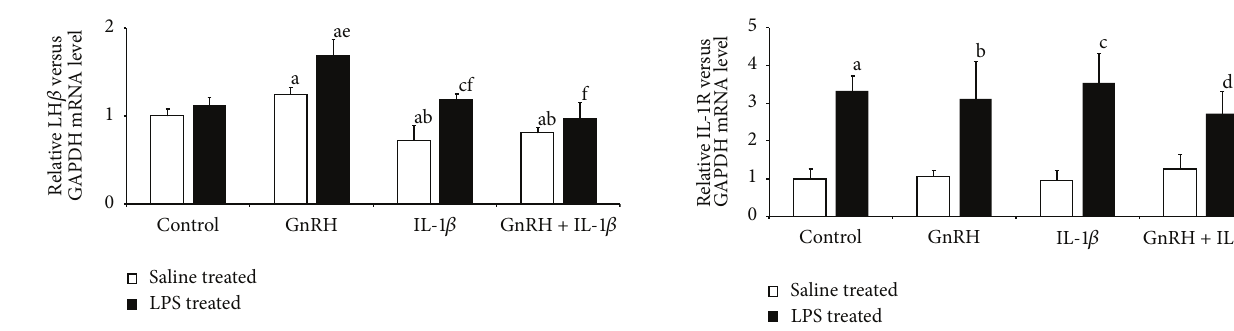
Figure 4: Stimulatory effect of LPS pretreatment on IL-1 type I receptor gene expression in the AP explants collected from saline- and LPS-treated ewes and incubated in four types of media (control—“pure” medium 199 HEPES; GnRH—medium with GnRH (100pmol/mL); IL-1 𝛽 —medium with IL- 𝛽 (100pg/mL); GnRH + IL-1 𝛽 medium with GnRH (100pmol/mL) and IL- 𝛽 (100pg/mL)). Data are presented as a median value ± SEM. a,b,c,d— 𝑃 ≤ 0.01 (indicating values that differ significantly from the control, GnRH, IL-1 𝛽 , and GnRH + IL-1 𝛽 groups of saline-treated explants, respectively, according to the Mann-Whitney 𝑈